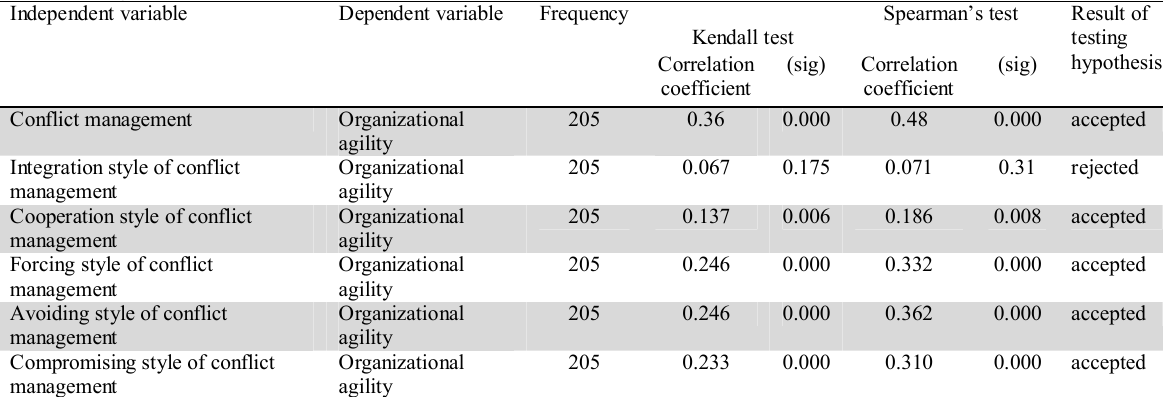
Measuring correlation of research